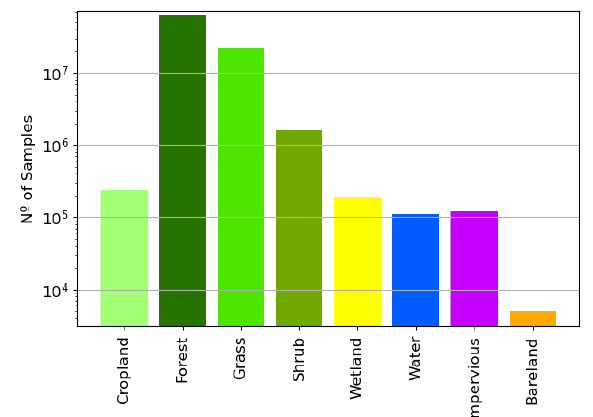
Figure 3. Available number of samples, i.e., pixels, within the 12 interferometric short time series stacks defined in Table 2 for every class considered in the FROM-GLC thematic maps. The class imbalance is a challenge for training and validating neural networks, as a prediction bias favors the detection of dominant